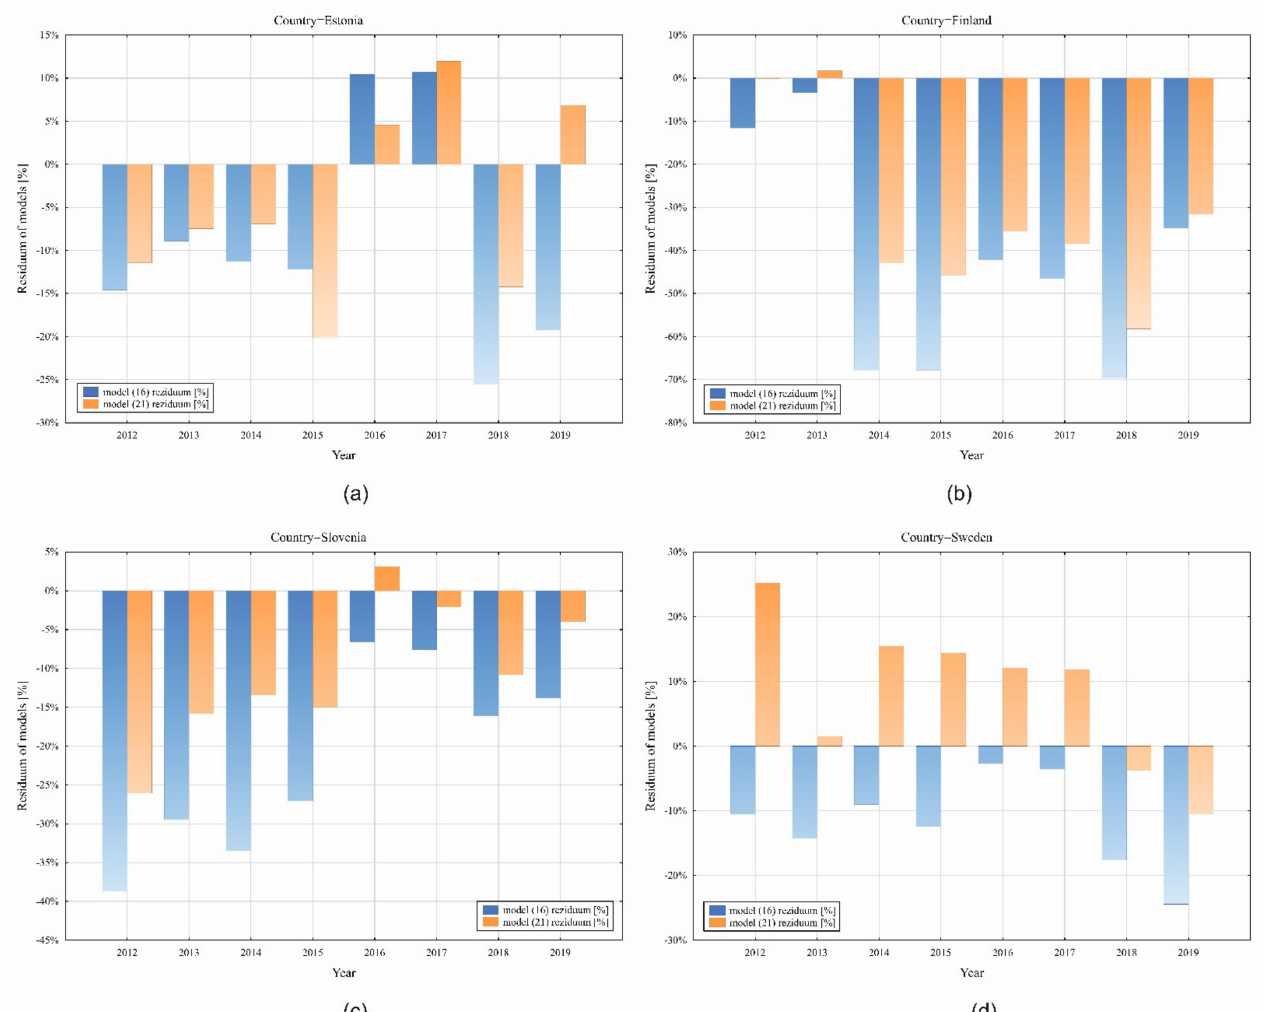
Figure 5. The relative value of the residuals of the analyzed PRM (16) and nonlinear (21) models,